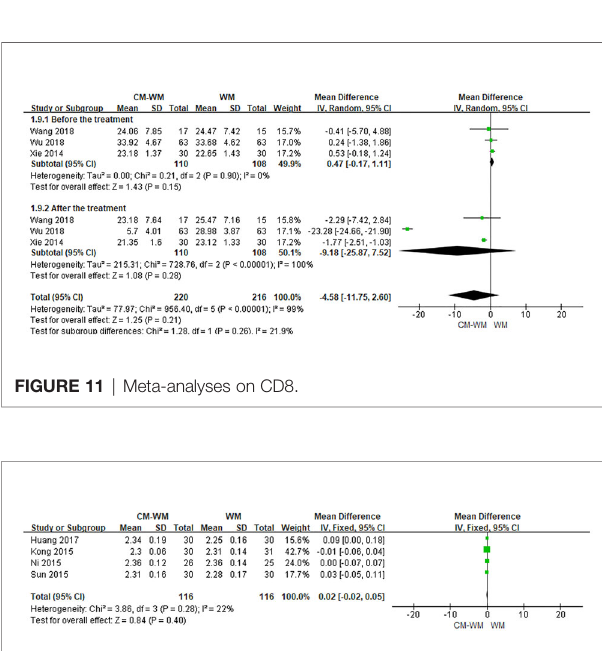
FIGURE 12 | Meta-analyses on Calcium.